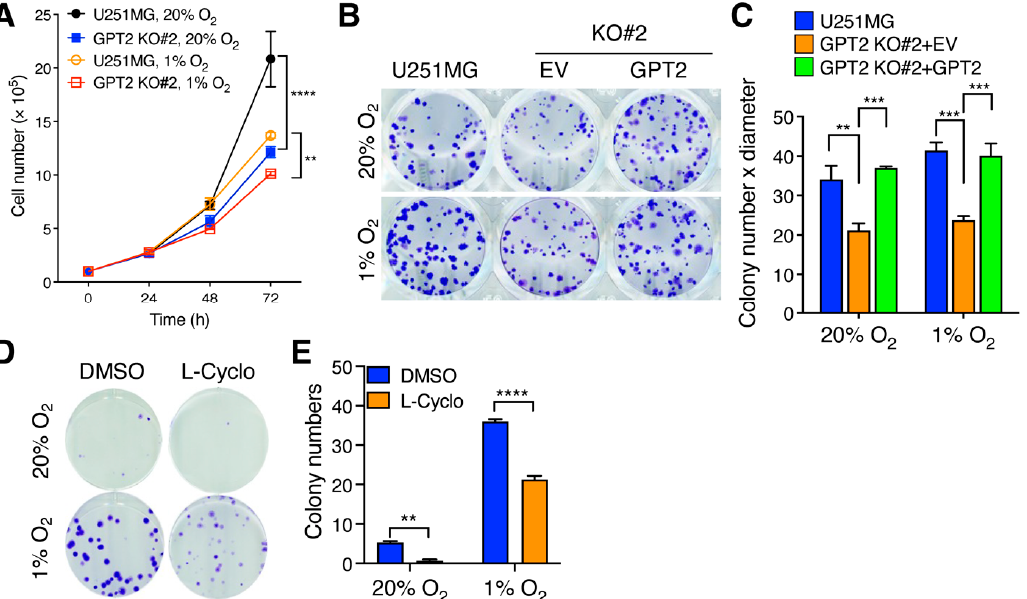
Figure 5. GPT2 promotes GBM cell growth in vitro. ( A ) Proliferation of parental and GPT2 KO U251MG cells exposed to 20% and 1% O 2 (mean ± SEM, n = 3). ** p < 0.01, **** p < 0.0001 by two-way ANOVA with Tukey’s test. ( B , C ) Colony formation of parental, GPT2 KO, and GPT2 rescue U251MG cells under 20% and 1% O 2 . Representative images are shown in ( B ). Quantification of colony growth is shown in ( C ) (mean ± SEM, n = 3). ** p < 0.01, *** p < 0.001 by two-way ANOVA with Tukey’s test. ( D , E ) Colony formation of U251MG cells exposed to 20% or 1% O 2 in the presence of DMSO or GPT2 inhibitor L-Cyclo (50 µ M). Representative images are shown in ( D ). Quantification of colony number is shown in ( E ) (mean ± SEM, n = 3). ** p < 0.01, **** p < 0.0001 by two-way ANOVA with Tukey’s test.